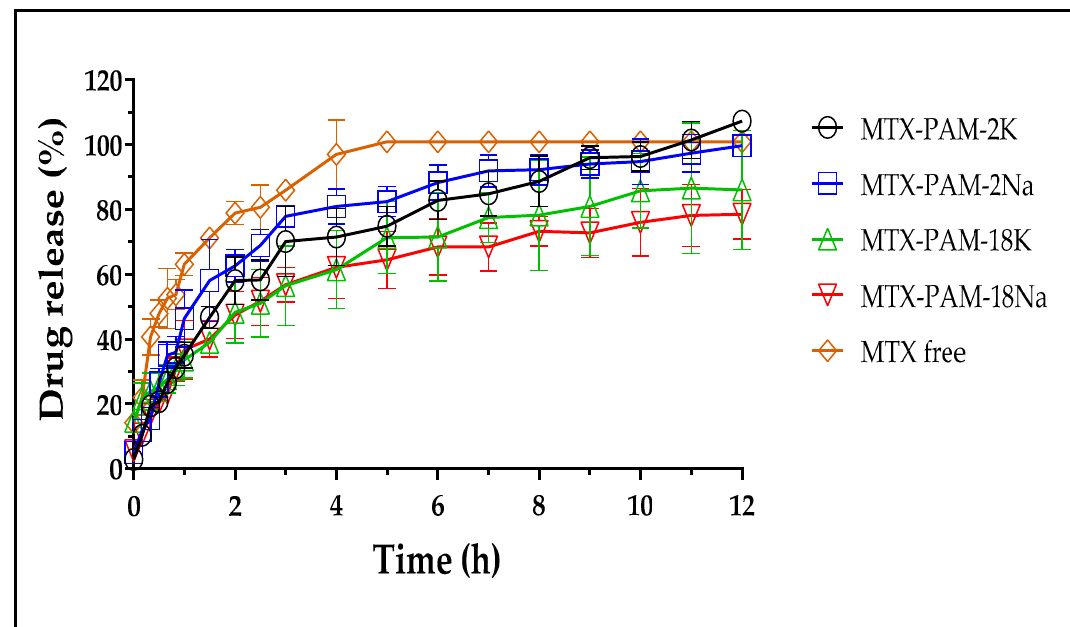
Figure 5. Methotrexate release profiles from nanoparticulate systems at 37 °C, 50 rpm and pH 7.4.